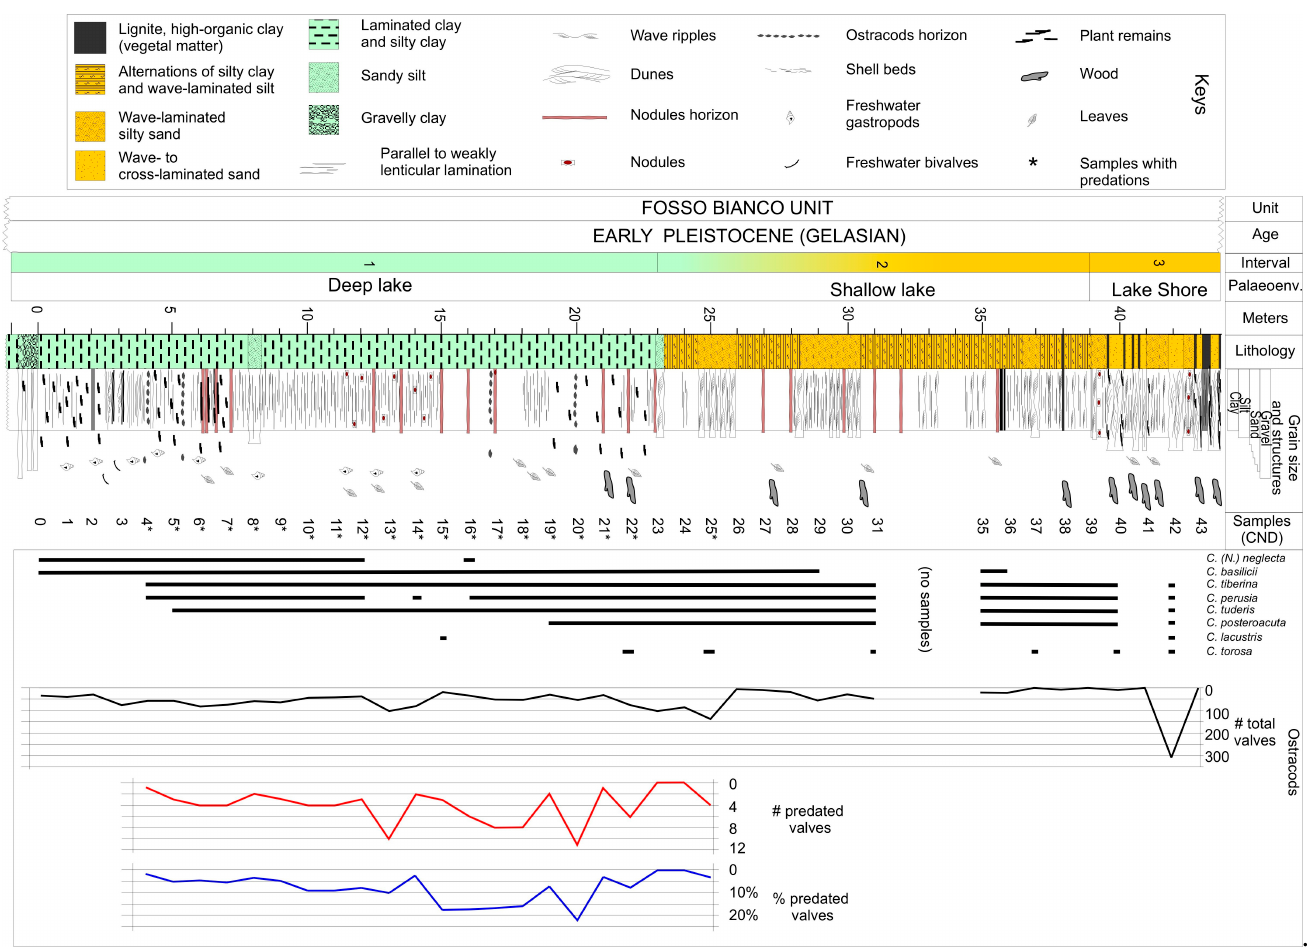
Figure 3. Sedimentological and stratigraphic log of the Cava Nuova section [34,35]. Main sedimentological structures, fossil content, distribution and frequency of ostracods (only disarticulated valves) and percentages of predated valves are reported.